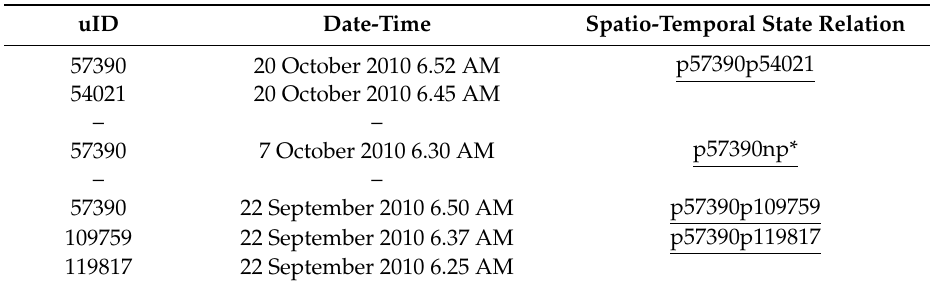
Figure 8. Visualisation of the trajectories of individuals who have been simultaneously spatially and temporally present in the “Midi Station” with the compared individual. The trajectory of the compared individual is represented in red, the three other colors represent the three persons connected to the first individual. Table 1. Usernames, and temporalities of individuals connected to the comparison individual with the username 57390 during his phases of presence in the “Midi Station”. In the example, a temporal tolerance of 15 min is applied to the check-in.